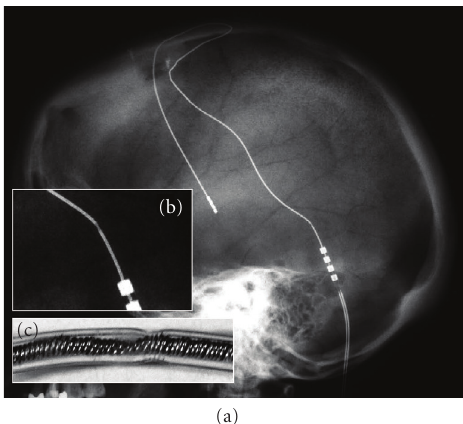
Figure 4: Incomplete lead fracture. (a) Rx of skull. (b) Detail of incomplete lead fracture. (c) A distortion of the explanted lead of (a) is observed.